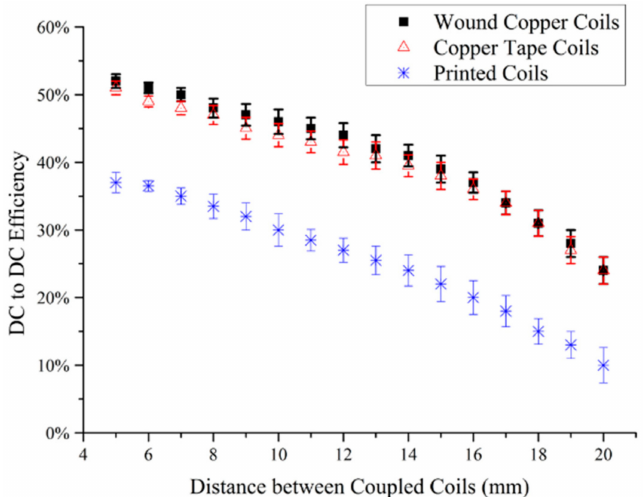
Figure 11. DC to DC efficiency at optimal output current against separation distance between different types of paired coils. The same trends of the effect of separation on DC to DC efficiency are shown on all types of coils.